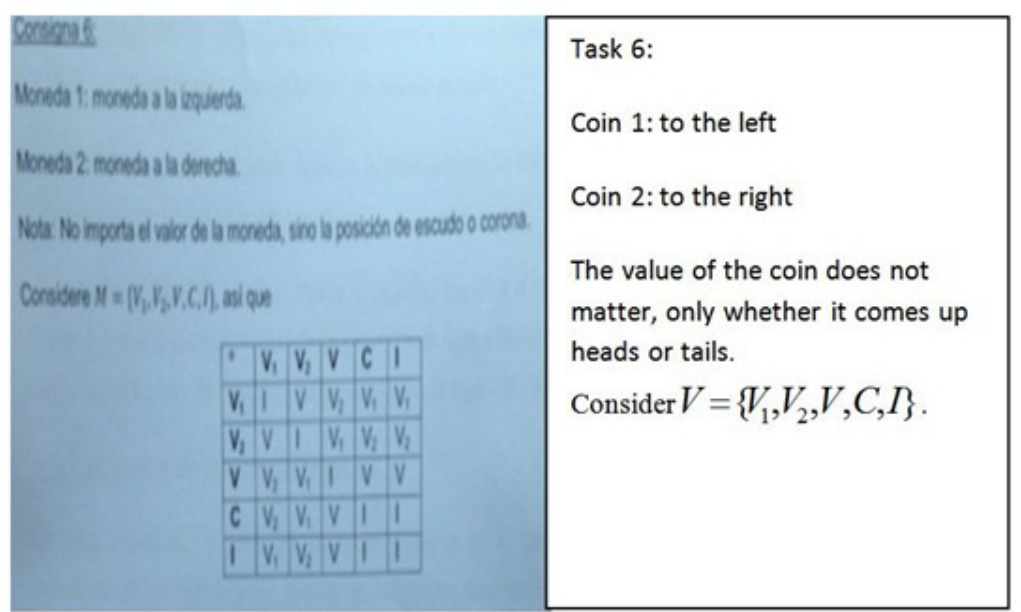
Figure 6. Operatons table with fve coin movements that are not a